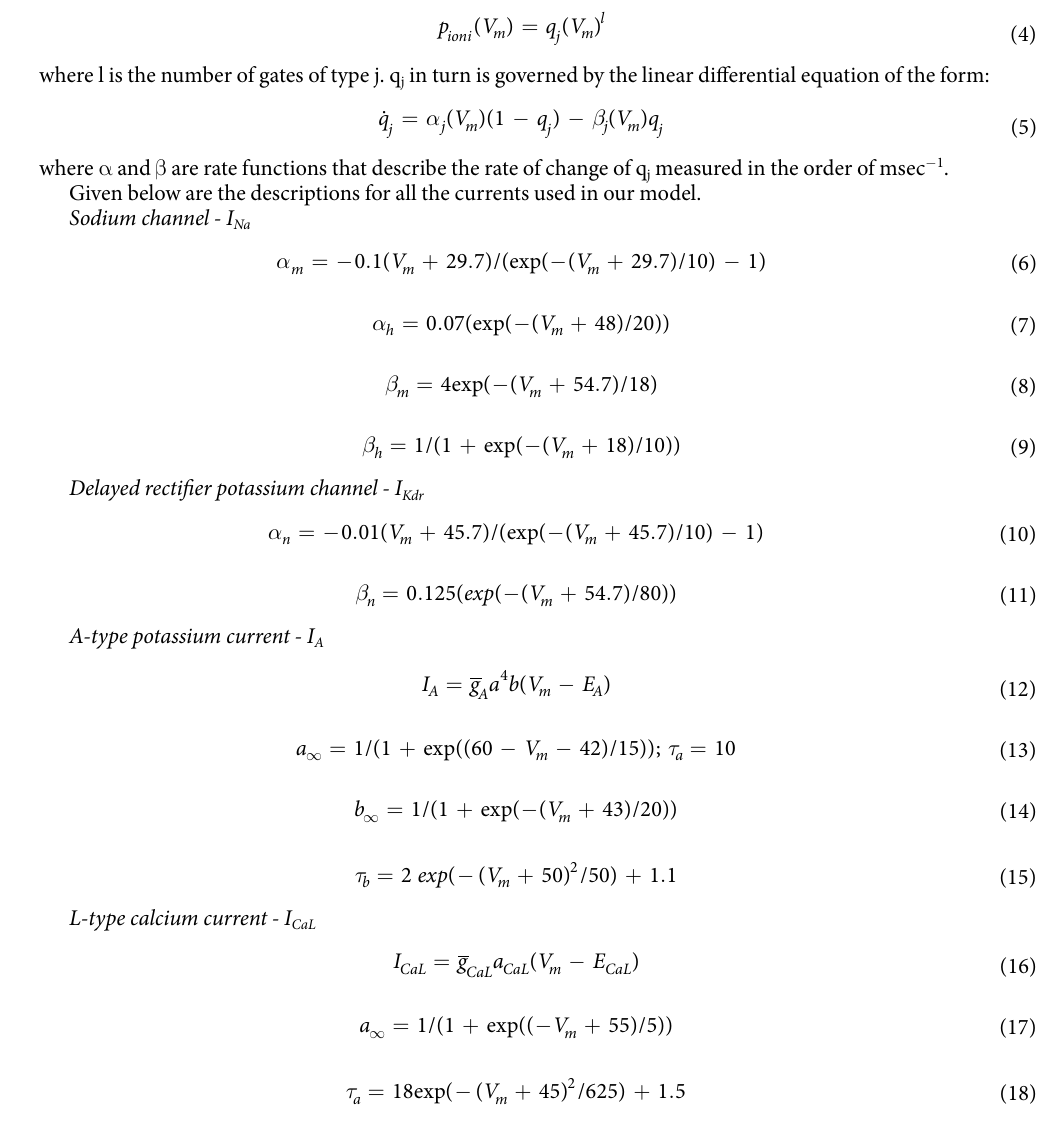
pendent of each other. If q j is the probability that a single gating particle j is in the bound state then,